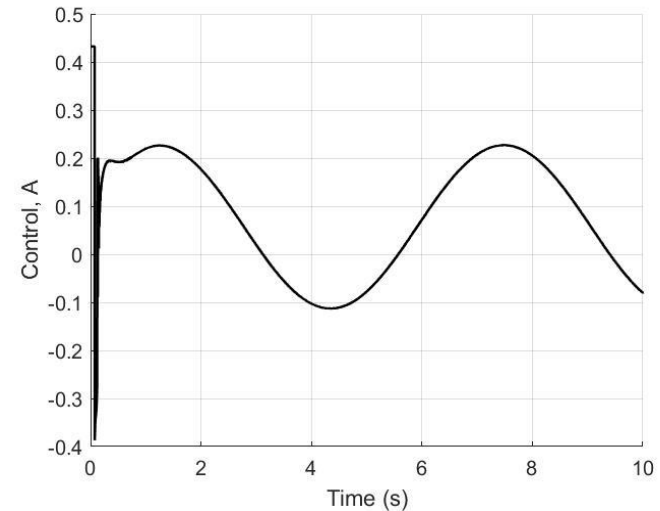
( a ) ( b ) Figure 13. Experiment 3. In ( a ), plots of the mixed variable )()( ( b ), plot of the estimation error  − Figure 13. Experiment 3. In ( a ), plots of the mixed variable )()( Figure 13. Experiment 3. In ( a ), plots of the mixed variable e 5 ( t ) = f 42 ( t ) and its estimate v 4 ( t ) ; in ( b ), plot of the estimation error  − ( b ), plot of the estimation error f 42 ( t ) − ν 4 ( t ) .